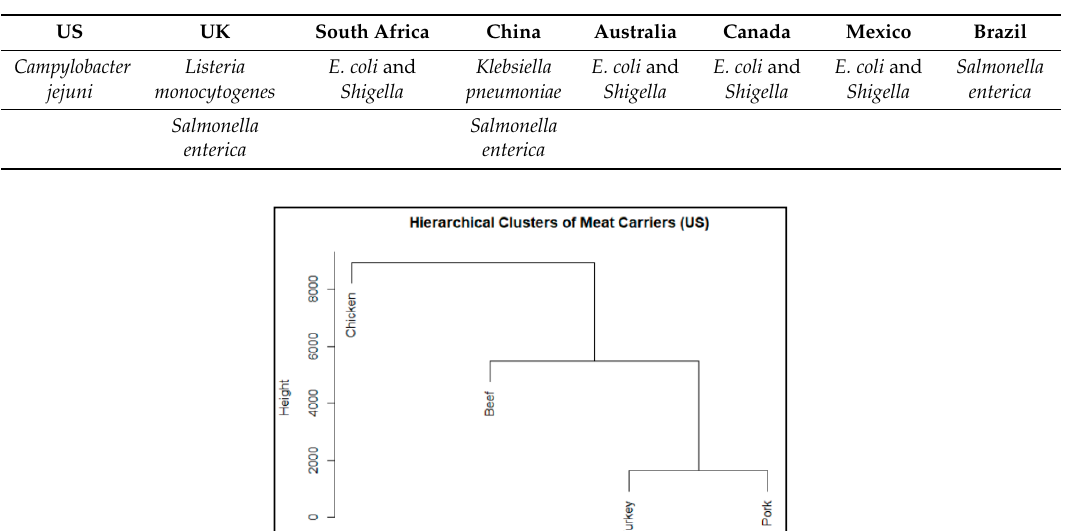
Figure 4. Frequency of highly-occurring pathogens over the years 2010–2019 in the US.